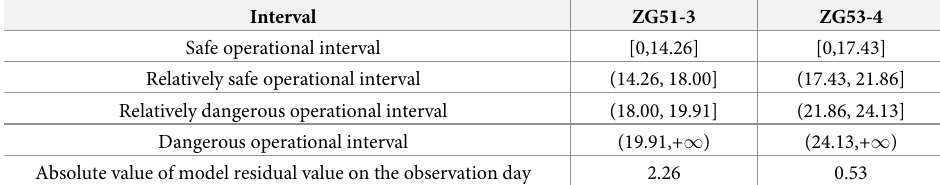
Table 8. Evaluation criteria table and observed daily residual